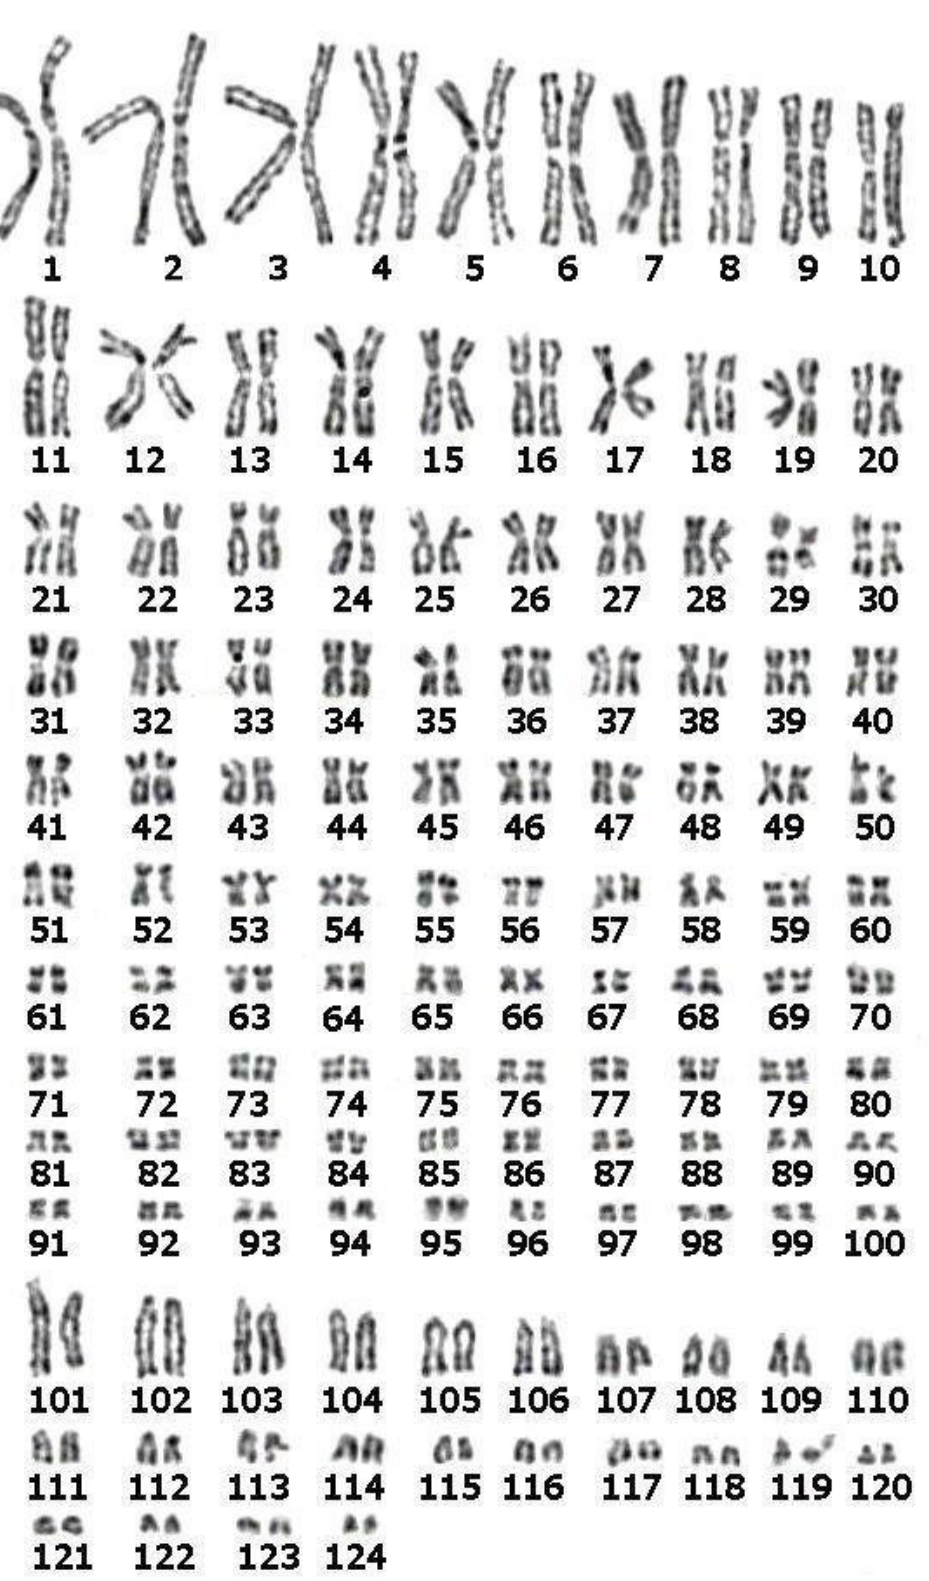
Figure 2. GTG-banded karyotype of the Siberian sturgeon ( Acipenser baerii ) (2n = 248). The morphologies of some homologs in pairs di ff er in this image (for example, pair 10). Observed heteromorphism was not confirmed by analyzing other metaphases and can be explained by either chromosome spreading artifact or by a rare chromosome